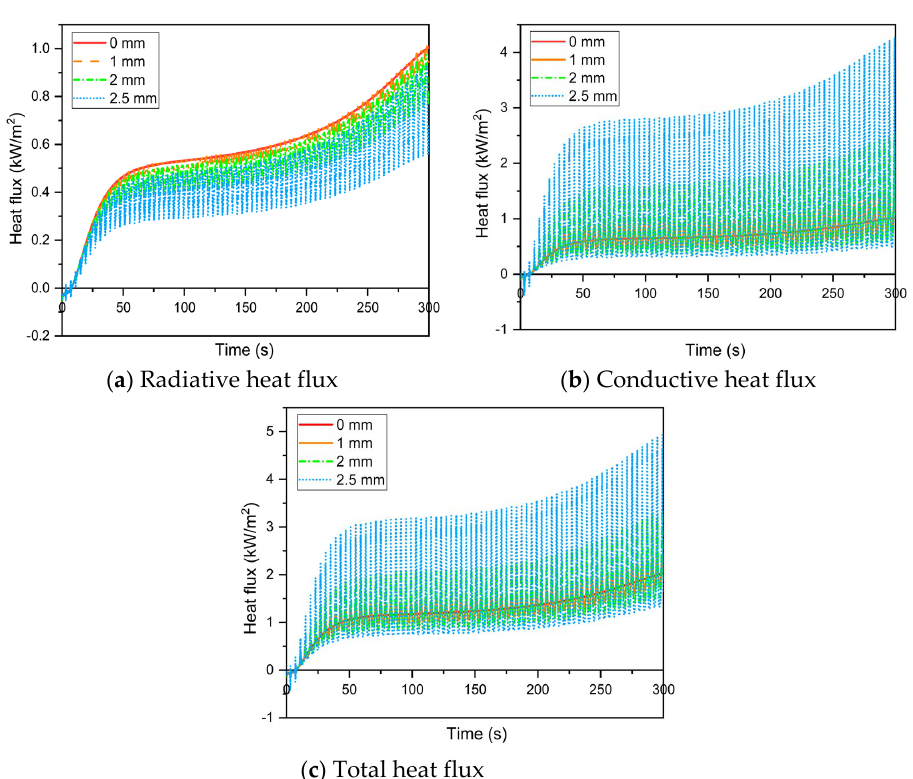
Figure 10. Effect of the fabric movement amplitude on radiative, conductive and total heat fluxes through the microenvironment between the thermal liner back surface and the skin.